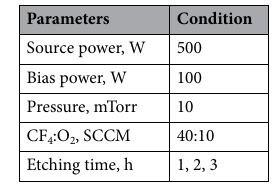
Table 1. Details of plasma etch